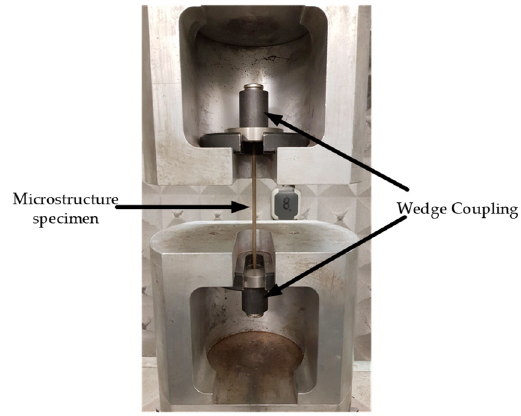
Figure 5. Test setup “fatigue test” of microstructure